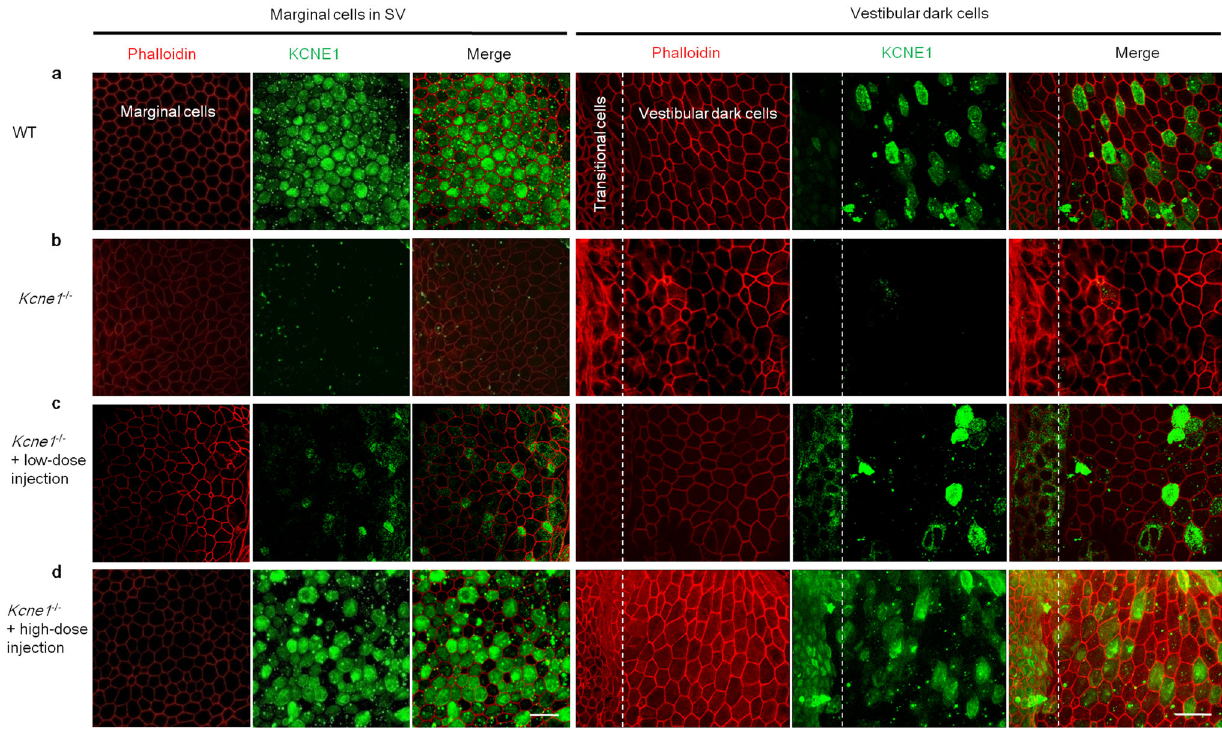
Fig. 2 Comparison of Kcne1 expression levels in marginal cells (MCs) and vestibular dark cells in WT mice, untreated Kcne1 − / − mice, and low- and high-dose-treated Kcne1 − / − mice at P30 ( n = 4 in each group). a Kcne1 expression in MCs and vestibular dark cells in WT mice. b Absence of Kcne1 expression levels in MCs and vestibular dark cells in untreated Kcne1 − / − mice. c Kcne1 expression levels were found in some MCs and vestibular dark cells in low-dose-treated Kcne1 − / − mice. d Extensive Kcne1 expression levels in MCs and vestibular dark cells in high-dose-treated Kcne1 − / − mice. Scale bar is 50 µ m and applies to all panels. Details of data quanti fi cations are given in the text. Red: phalloidin; Green: